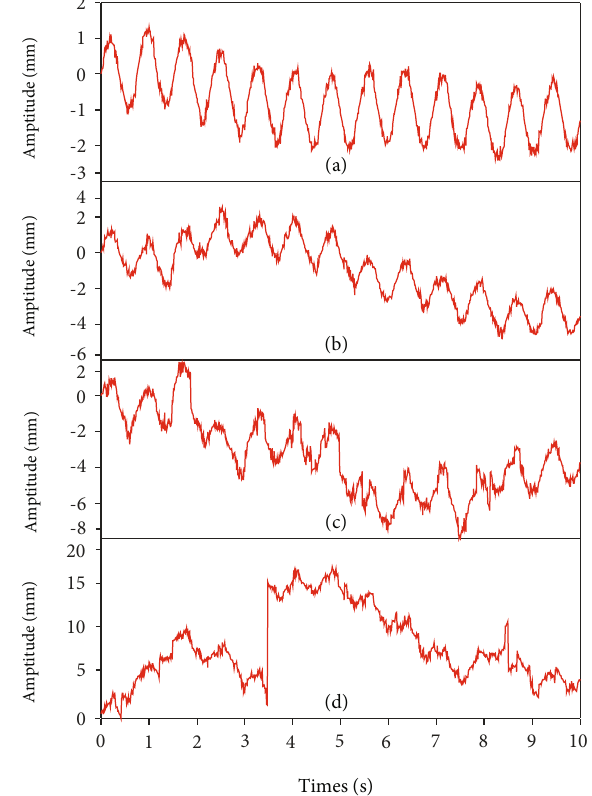
Figure 3: The demodulation result in time domain for simulated signal with di ff erent SNR: (a) SNR = 13dB , (b) SNR = 10dB , (c) SNR = 7dB , and (d) SNR = 5dB